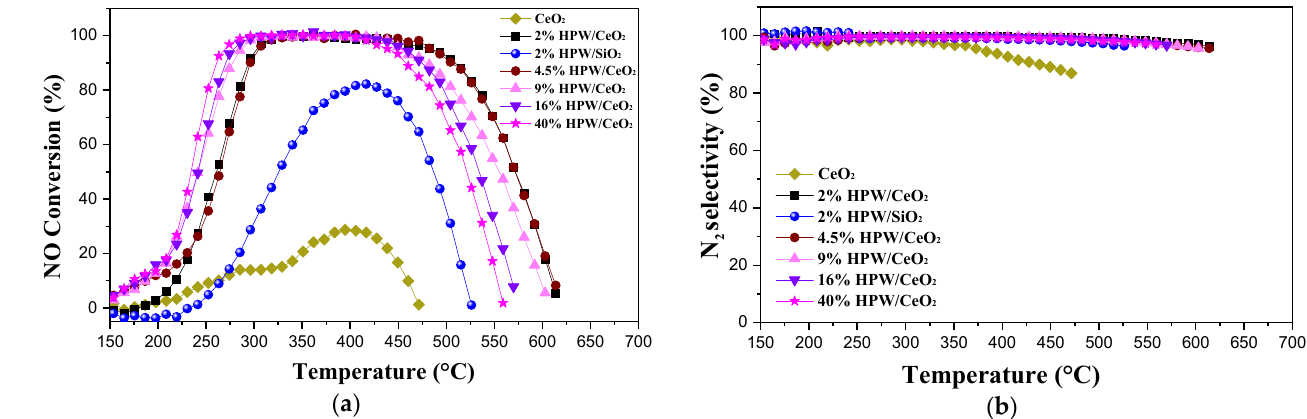
Figure 6. Activity ( a ) and N 2 selectivity ( b ) of CeO 2 , HPW/CeO 2 (2, 4.5, 9, 16, and 40 wt% W) and 2% HPW/SiO 2 . Condition: [NH 3 ] = 350 ppm, [NO] = 300 ppm and GHSV = 30,000 h − 1